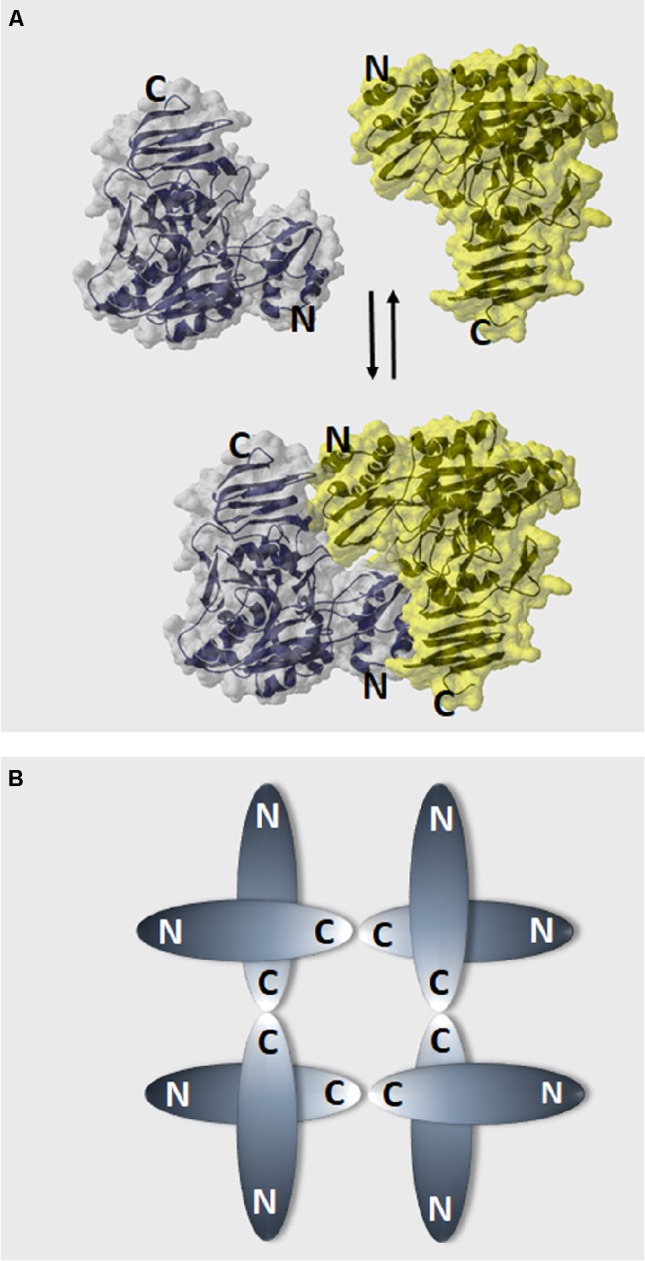
Models of plant UGPase dimer formation and the oligomerization state of human and yeast UGPases. (A) “Head-to-toe” dimer of Arabidopsis UGPase (McCoy et al., 2007), where N-terminal domain of one monomer faces C-terminal domain of the other. Surface and ribbon representations (PDB code: 2ICX) were built using Swiss PDB viever. (B) A schematic drawing of the “toe-to-toe” arrangement of the human and yeast UGPase octamer, where oligomerization occurs via interaction of the C-termini domains of the monomers (Roeben et al., 2006; Führing et al., 2013b).